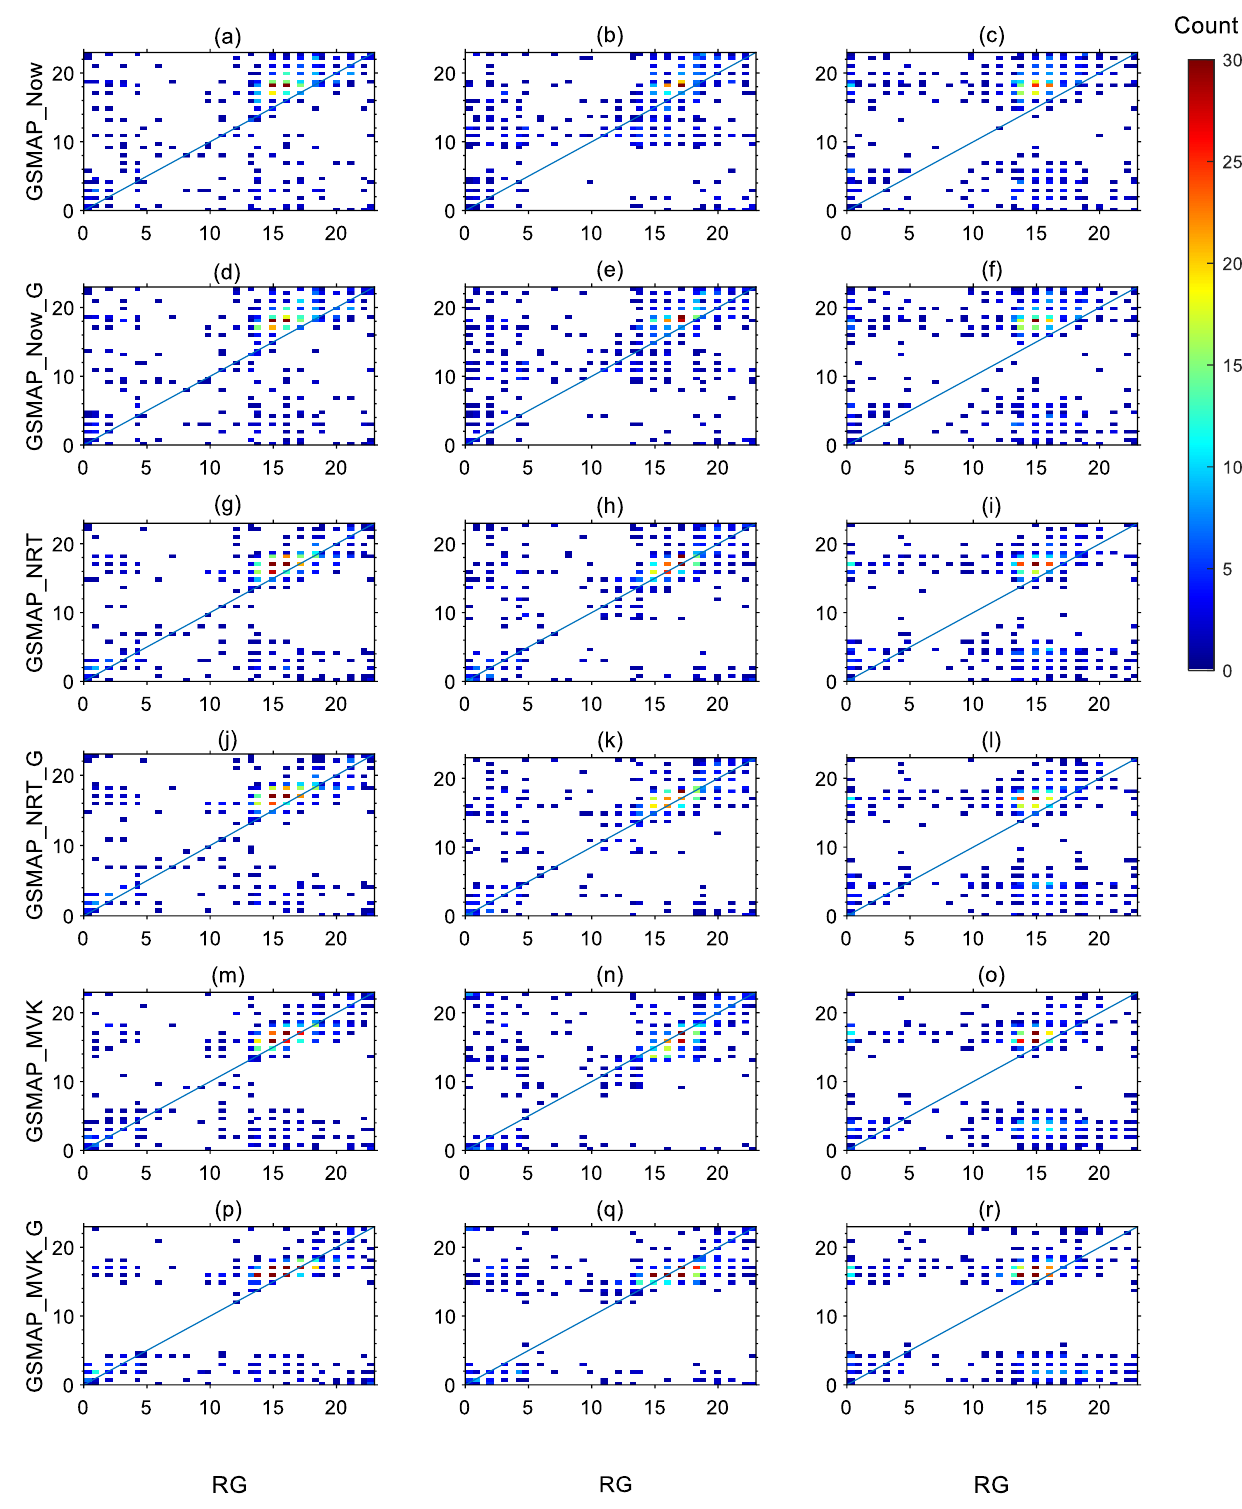
Figure 4. Peak time of PA (left column), PF (Center column), and PI (right column) for GSMaP_Now ( a – c ), GSMaP_Now_G ( d – f ), GSMaP_NRT ( g – i ), GSMaP_NRT_G ( j – l ), GSMaP_MVK ( m – o ), and GSMaP_Gauge ( p – r ).